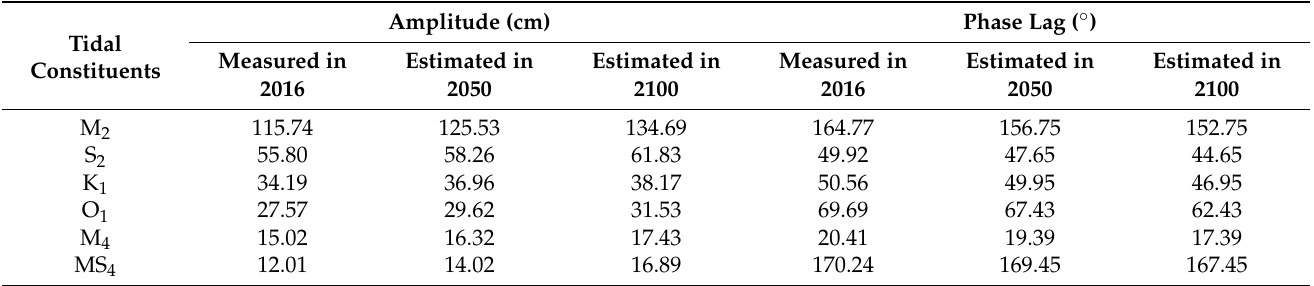
Table 4. Tidal constituent amplitude and phase changes in the estuary of Kampar as a response to sea level